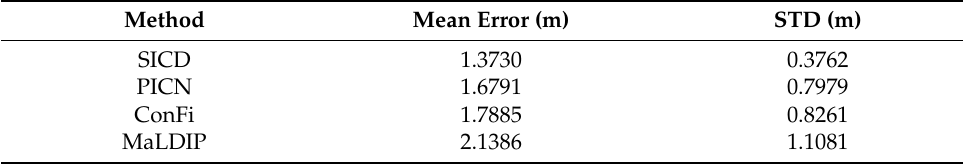
Table 2. Localization errors with CSI-based methods.